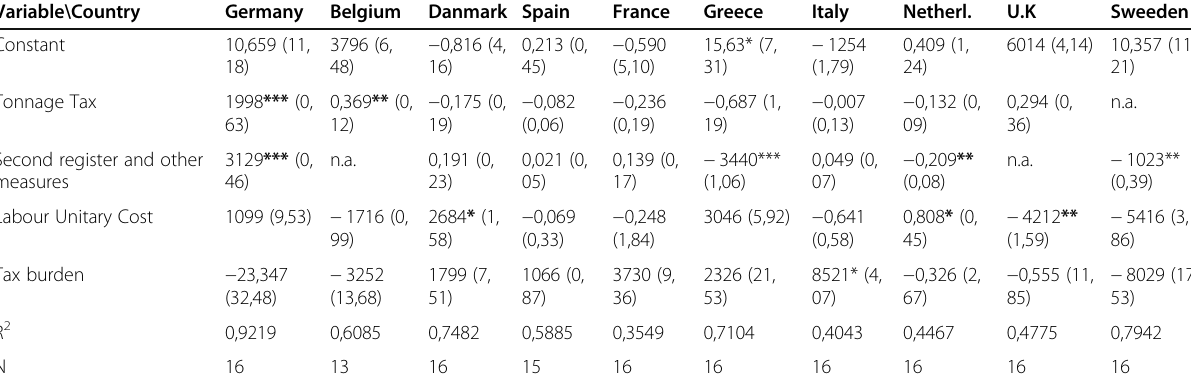
Table 7 Regression estimates of impact of maritime transport policy measures on controlled fleet (country-specific model)